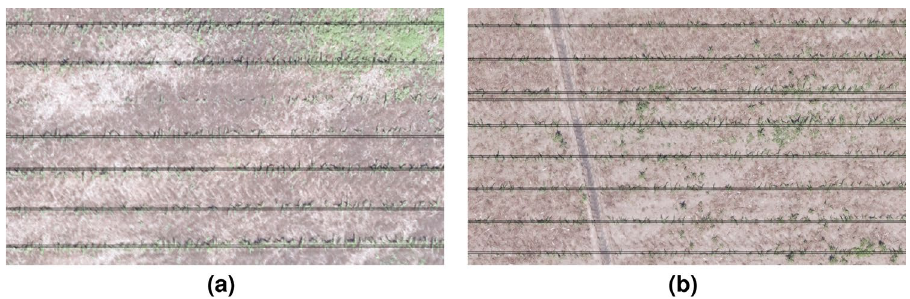
Figure 7. ( a ) Sample image where the proposed CRI algorithm failed to detect an existent corn row as a line on the ExGI imagery of a corn field, ( b ) Sample image where the proposed CRI algorithm detected two lines over a single corn row on the ExGI imagery of a corn